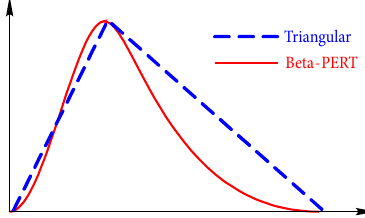
Fig. 4. Illustration of the PERT distribution compared with a triangular distribution with the same input parameters Table 6. Results from a deterministic run of the UNITE-DSS model applying the Optimism Bias uplifts with 80% certainty Rail